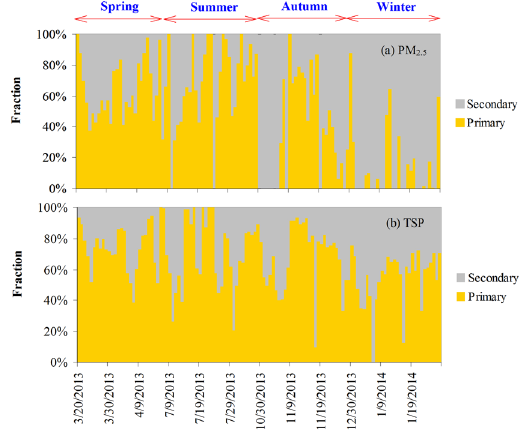
Figure 5. Quantitative assessment of contribution of primary and secondary sources to the total SO 42 − in TSP and PM 2.5 over Hotan. No PM 2.5 data were available during the period of October 30–5 November,